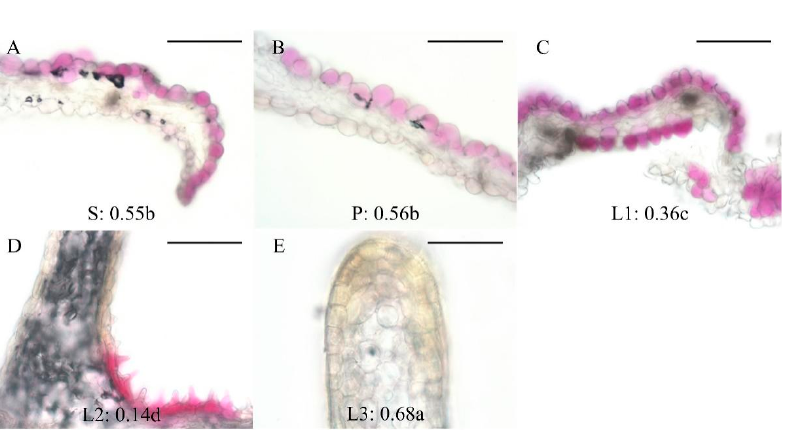
Figure 5. Cell shapes and shape index. ( A ) Sepal, ( B ) Petal, ( C ) Lip1, ( D ) Lip2, ( E ) Lip3 (ridge on the Lip2). Groups annotated with the same letter are not significantly different, according to LSD Test ( p < 0.05). Bars represent 200 μ m in all panels.